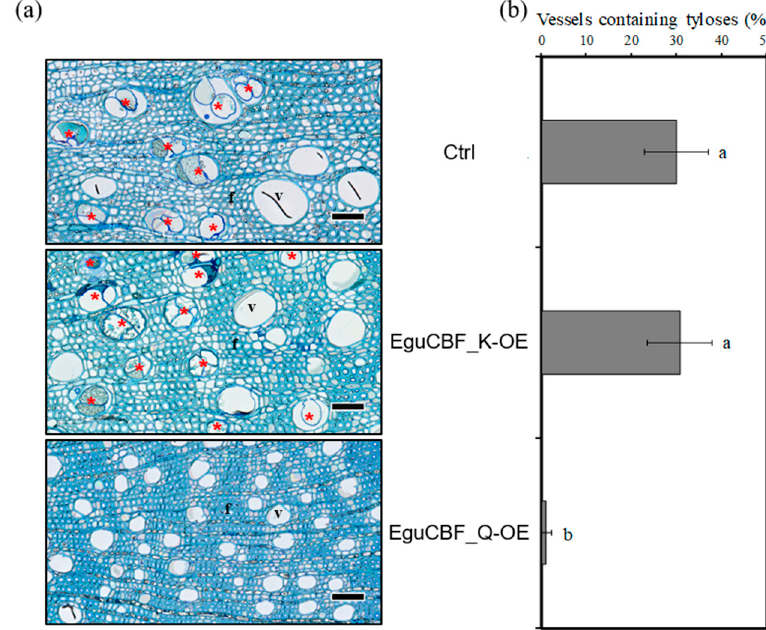
Figure 5. Presence of tyloses in the inner part of the xylem. ( a ) Toluidine blue O stained cross sections of the inner part of the secondary xylem of 6-month-old plants, vessels containing tyloses are highlighted by red stars. ( b ) Percentage of vessels containing tyloses quantified in stem sectors delimitated by ray cells from pith to cambium. A total of 44 to 1915 vessels with tyloses were counted per line, across 3 biological replicates. Statistical significance was assessed with one-way ANOVA and Tukey HSD post hoc test ( p < 0.05; groups identified with letters a, b and c). Scale bar = 50 µm.